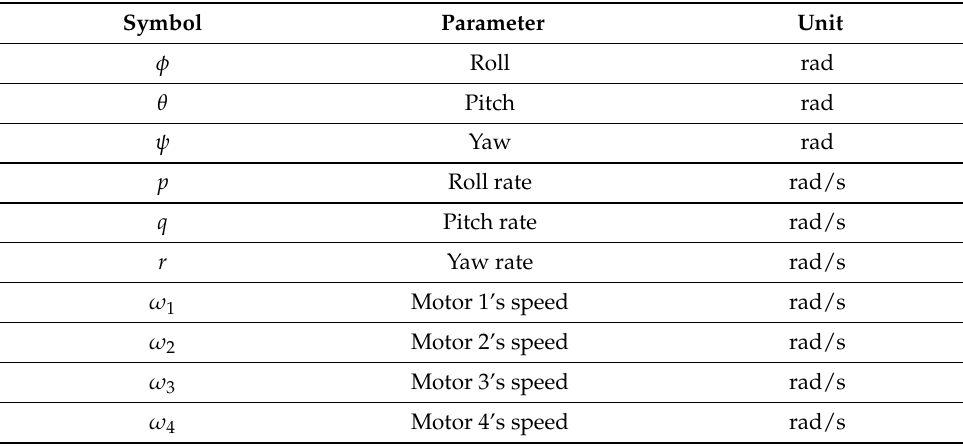
Table 1. Variables used for estimator